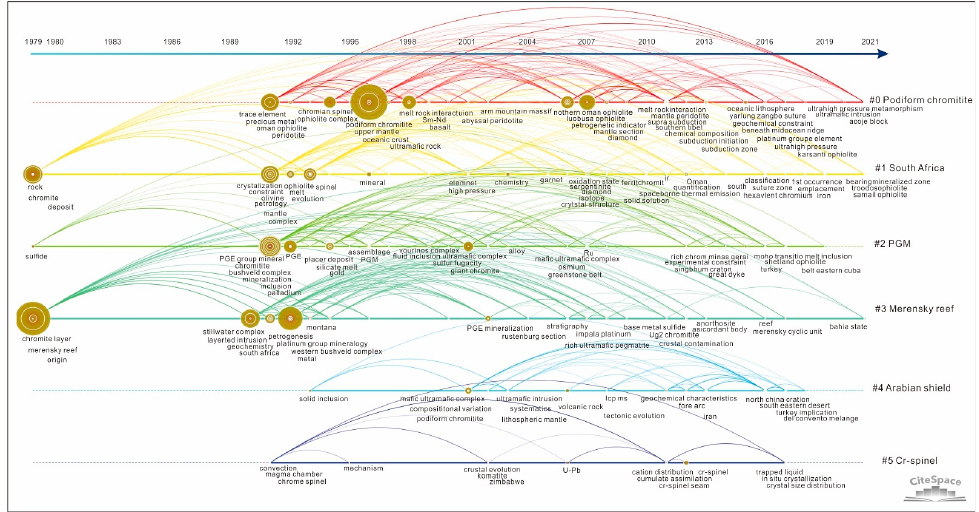
Figure 8. Timeline of co-citation clusters for keywords. Figure 8.